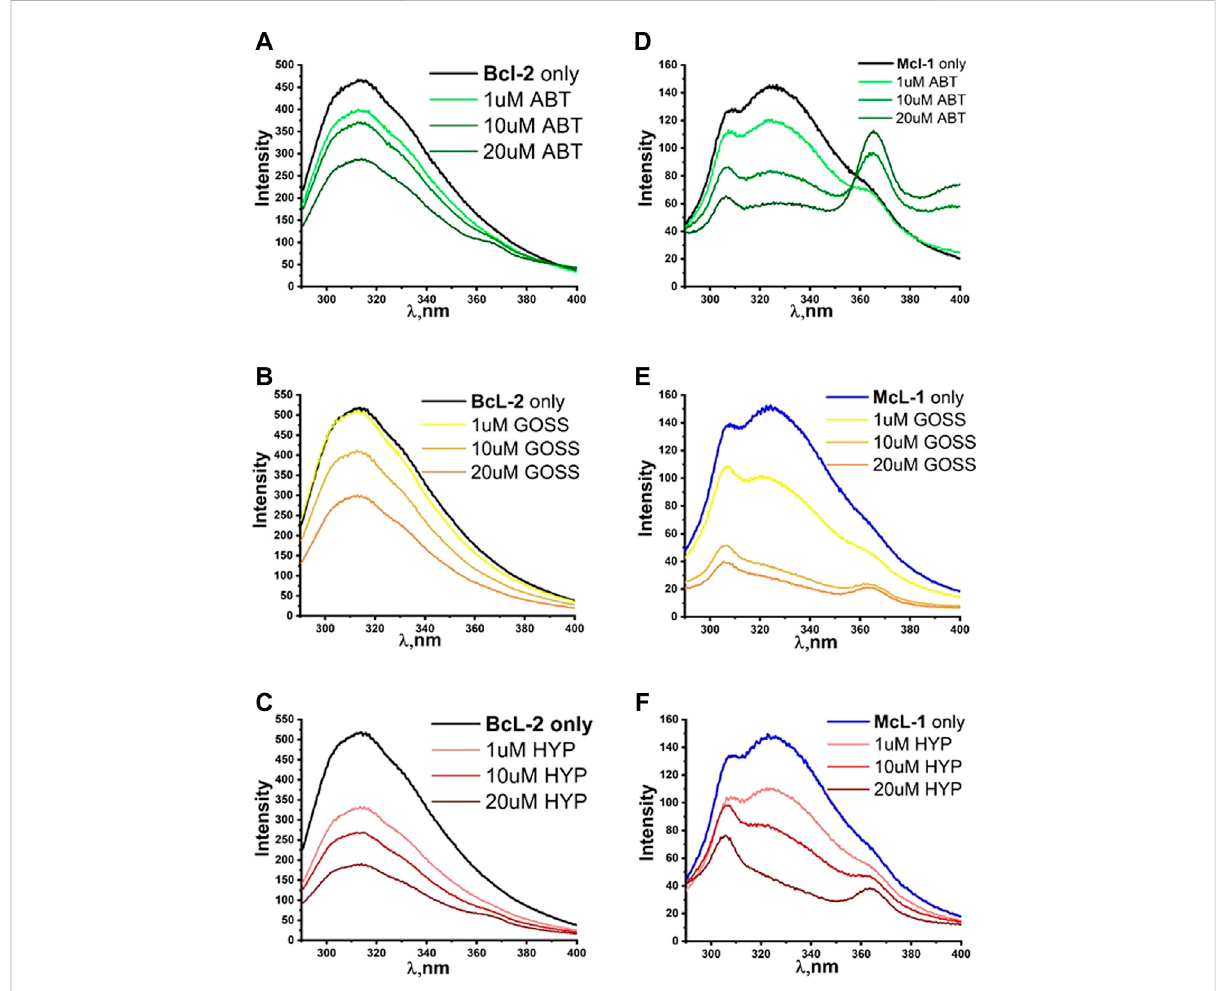
FIGURE 4 The fl uorescence quenching spectra of Bcl2 and Mcl1. The fl uorescence quenching spectra of Bcl2 (A – C) and Mcl1 (D – F) proteins (1 μ M) with different concentration of ABT263, Goss and Hyp in PBS. Bcl2 spectra were measured with excitation wavelength of 280 nm and Mcl1 spectra with excitation wavelength of